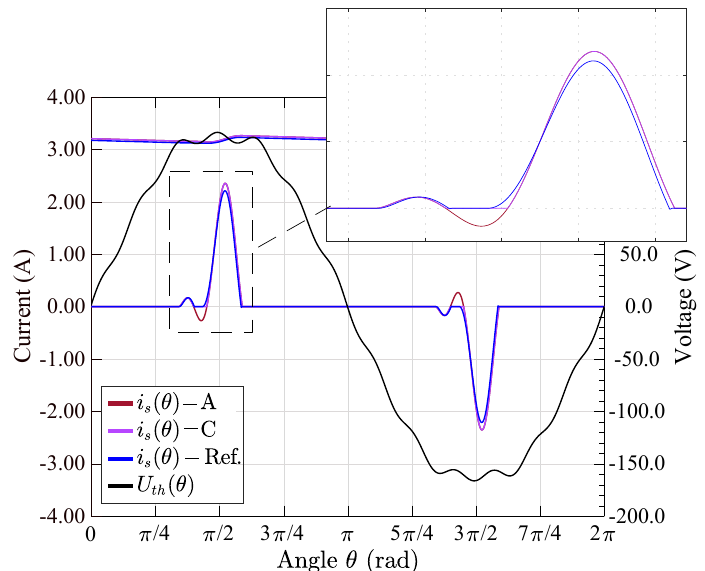
Figure 3. Voltage and current waveforms obtained from models A, C, and numerical solution for flat-top 2 voltage ( FT 2 ) and inductive source ( Z 3